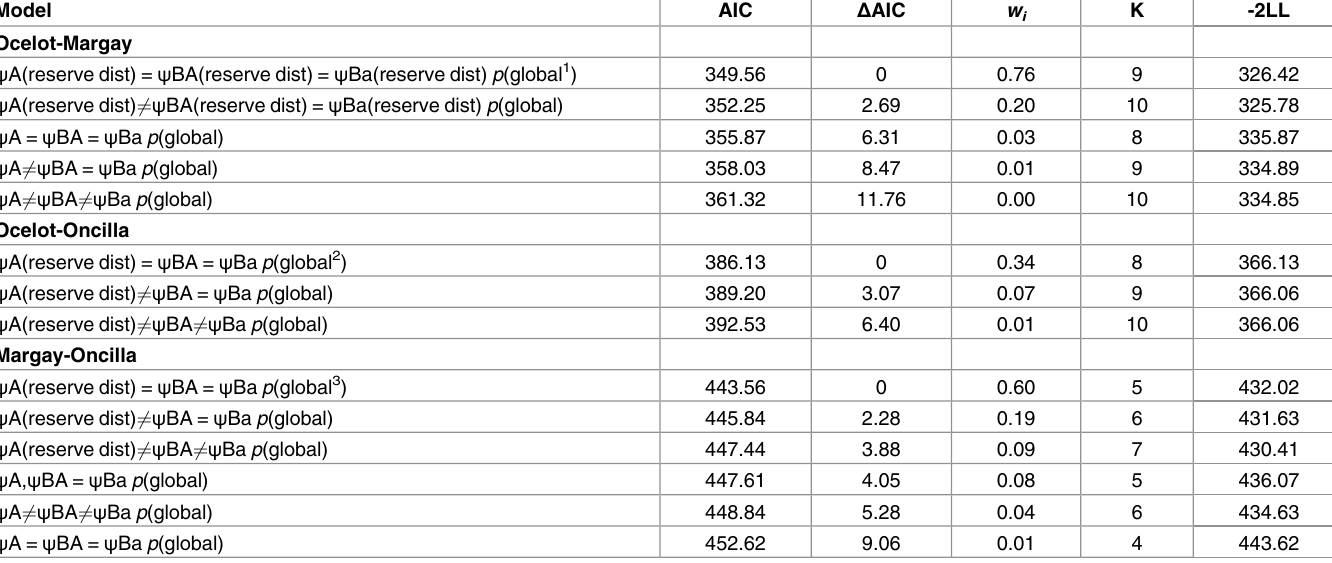
Table 2. Co-occurrence occupancy models used to evaluate the role of interspecific interactions on the habitat use of three sympatricNeotropical spotted cats in a large Atlantic Forest remnant.